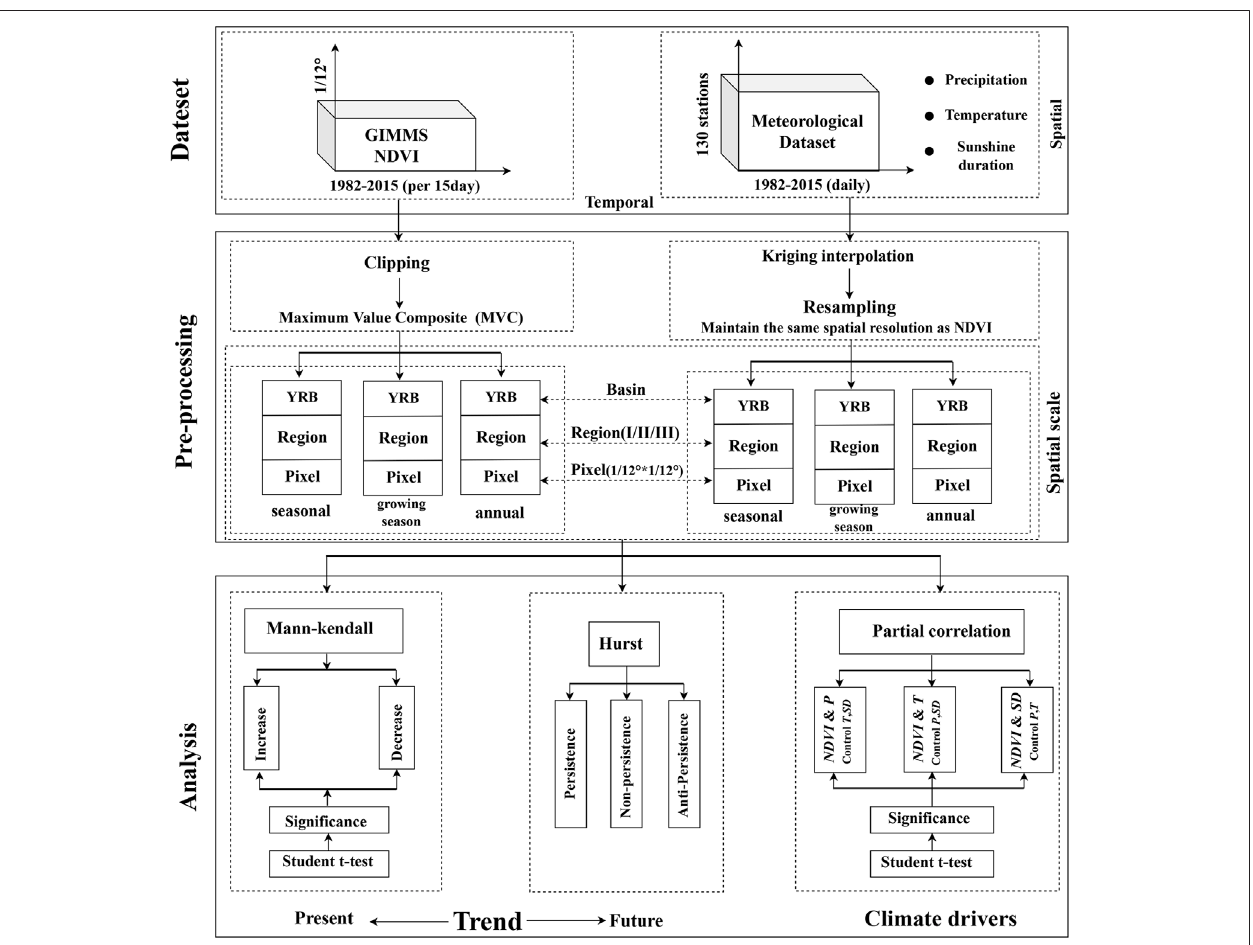
FIGURE 2 | The schematic diagram of the study.